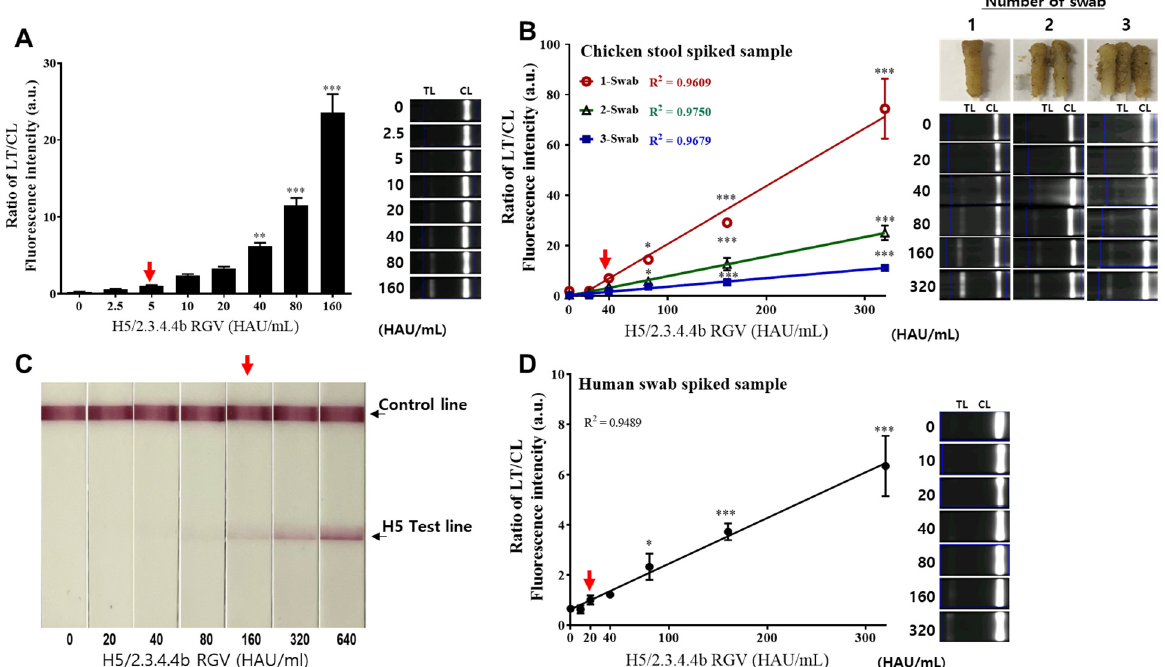
Figure 6. FICT LoD against serial dilution of H5 RGV. Serial dilution of H5/2.3.4.4b RGV was performed in deionized sterile water (DW) or mimic samples and then subject to FICT using a colloidal gold-based RDT kit. ( A ). TL/CL ratio in DW. ( B ). TL/CL ratio in chicken stool spiked samples. 0.3 g of chicken stool was mixed with 0.3 mL of diluted H5/2.3.4.4b RGV and then transferred to 0.5 mL of lysis buffer by using cotton swabs. Finally, 200 μ L of each sample was dropped onto a test strip after a 30 s spin. ( C ). Colloidal gold-based RDT kit with the selected mAb pair. ( D ). Spiked human nasal swab samples. After mixing the diluted virus in the human swab sample, 75 μ L of the sample plus 125 μ L of lysis buffer was used for FICT. The red arrow indicates the virus titer representing the LoD of FICT. Data are mean ± SD ( n = 3). The linear regression (dotted line) showed R 2 > 0.9. One-way ANOVA was used to analyze the FICT data. * p < 0.05; ** p < 0.01; *** p < 0.001 in relation to the control group. Raw fluorescence peaks for the test line (TL) and control line (CL) of FICT are shown in Supplementary Figure S7.